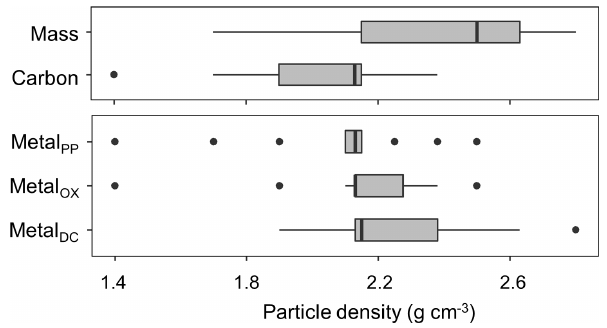
Figure 5. Boxplot showing the median and distribution of the den- sities at which the distribution of mass, C, and pedogenic metal (Al + 0.5Fe) extracted by the three extractants (PP, OX, and DC) were the highest among the 23 studied